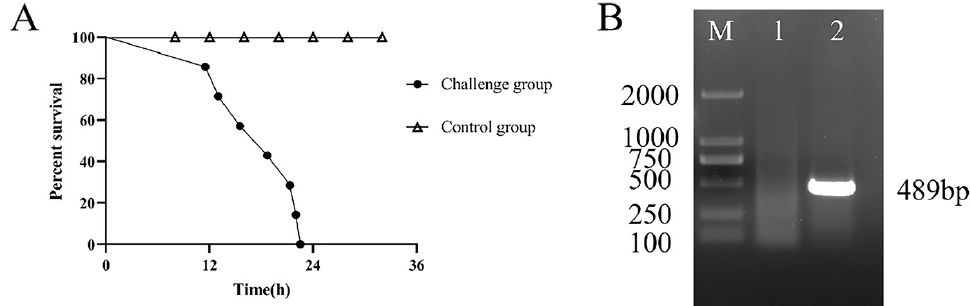
Figure 3. Pathogenicity test results of K. pneumoniae . ( A ) Line chart of survival rate of K. pneumoniae - infected mice. ( B ) Electrophoresis results of KHE gene amplification in K. pneumoniae . “M” represents DL2000 DNA Marker. “1” represents negative control; “2” represents TSA single colony (The original gel figure can be found in Supplementary Figure S1).